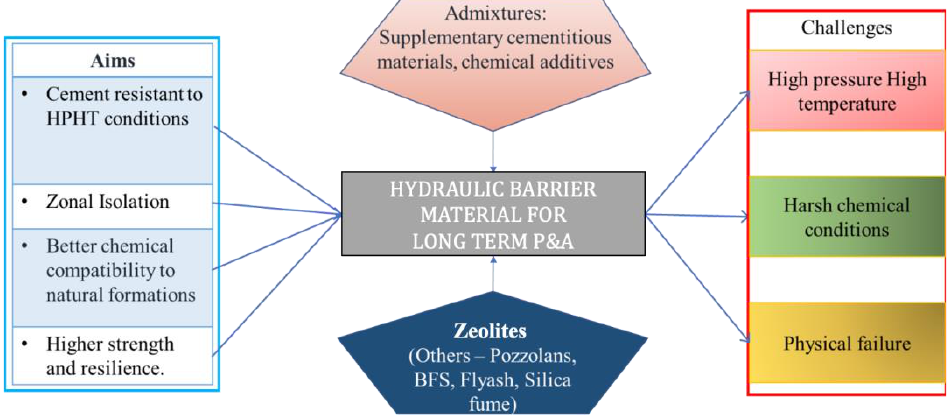
Figure 2. Challenges in usage of cement for subsurface conditions, additives and the aims of P&A.